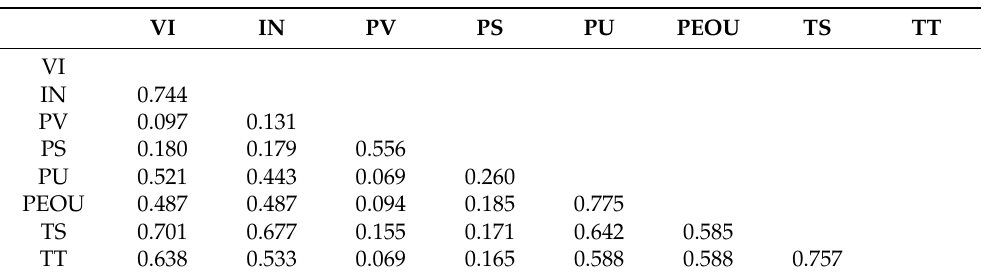
Table 4. Discriminant Validity (HTMT).